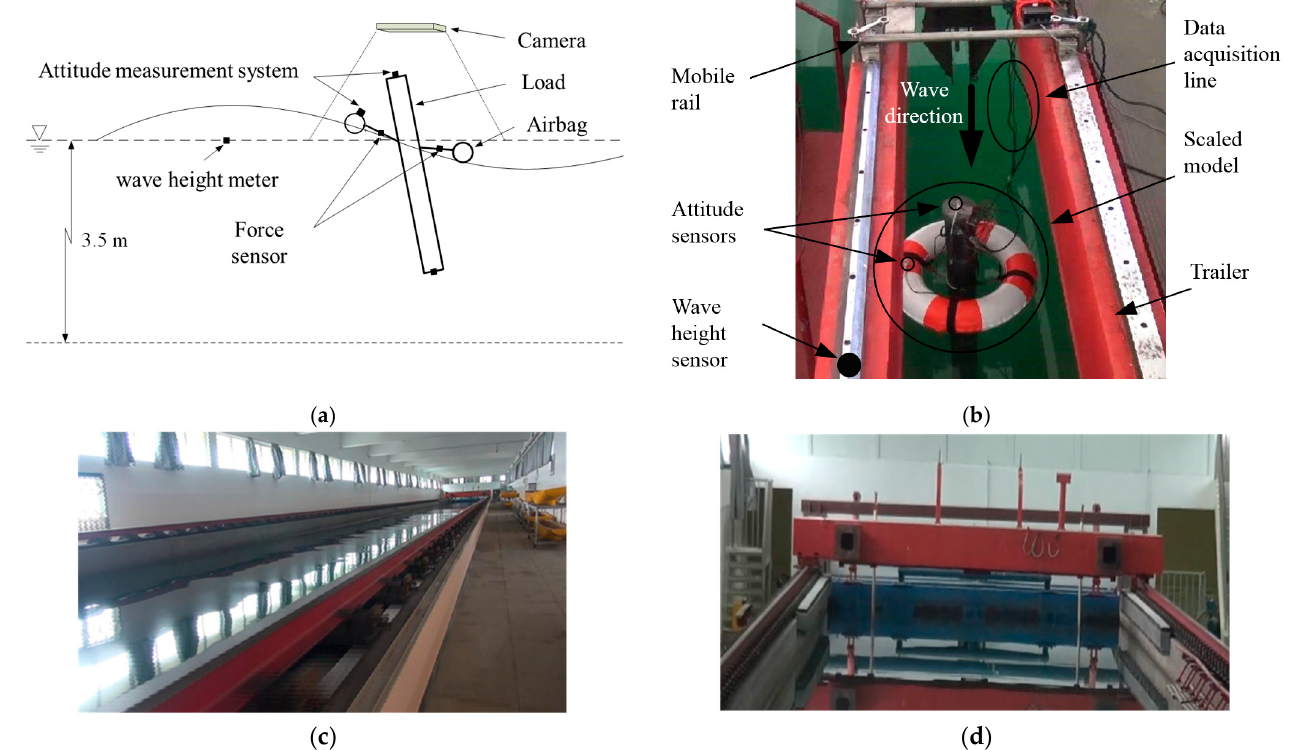
Figure 16. Experiment setup for scaled model verification ( a ) Sketch of the experiment setup, ( b ) Experiment setup, ( c ) The towing tank, ( d ) The wave generator.